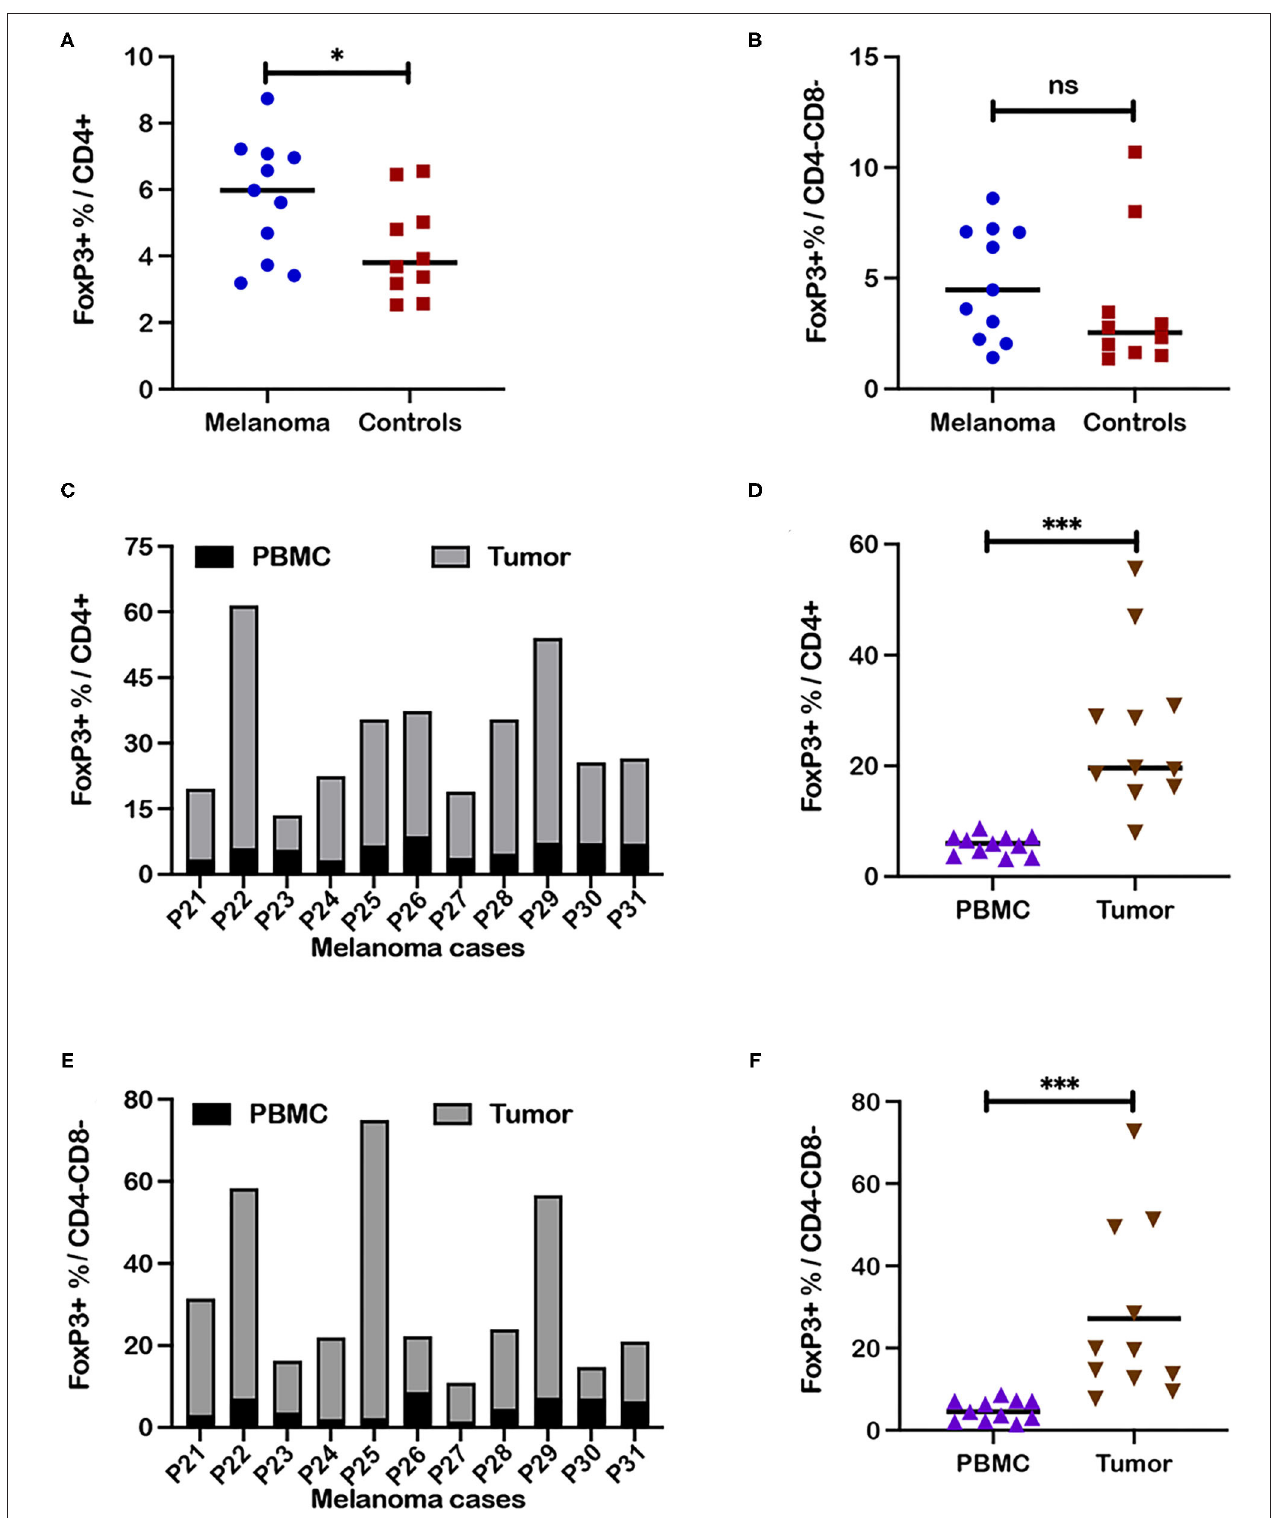
FIGURE 7 | Comparison of frequencies of regulatory T cell subsets in tumor associated cells and blood in canine melanoma patients. PBMC isolated from blood and tumor associated cells from a separate cohort of 11 canine melanoma patients were assessed for T cell phenotypes by flow cytometry. (A) Median frequencies